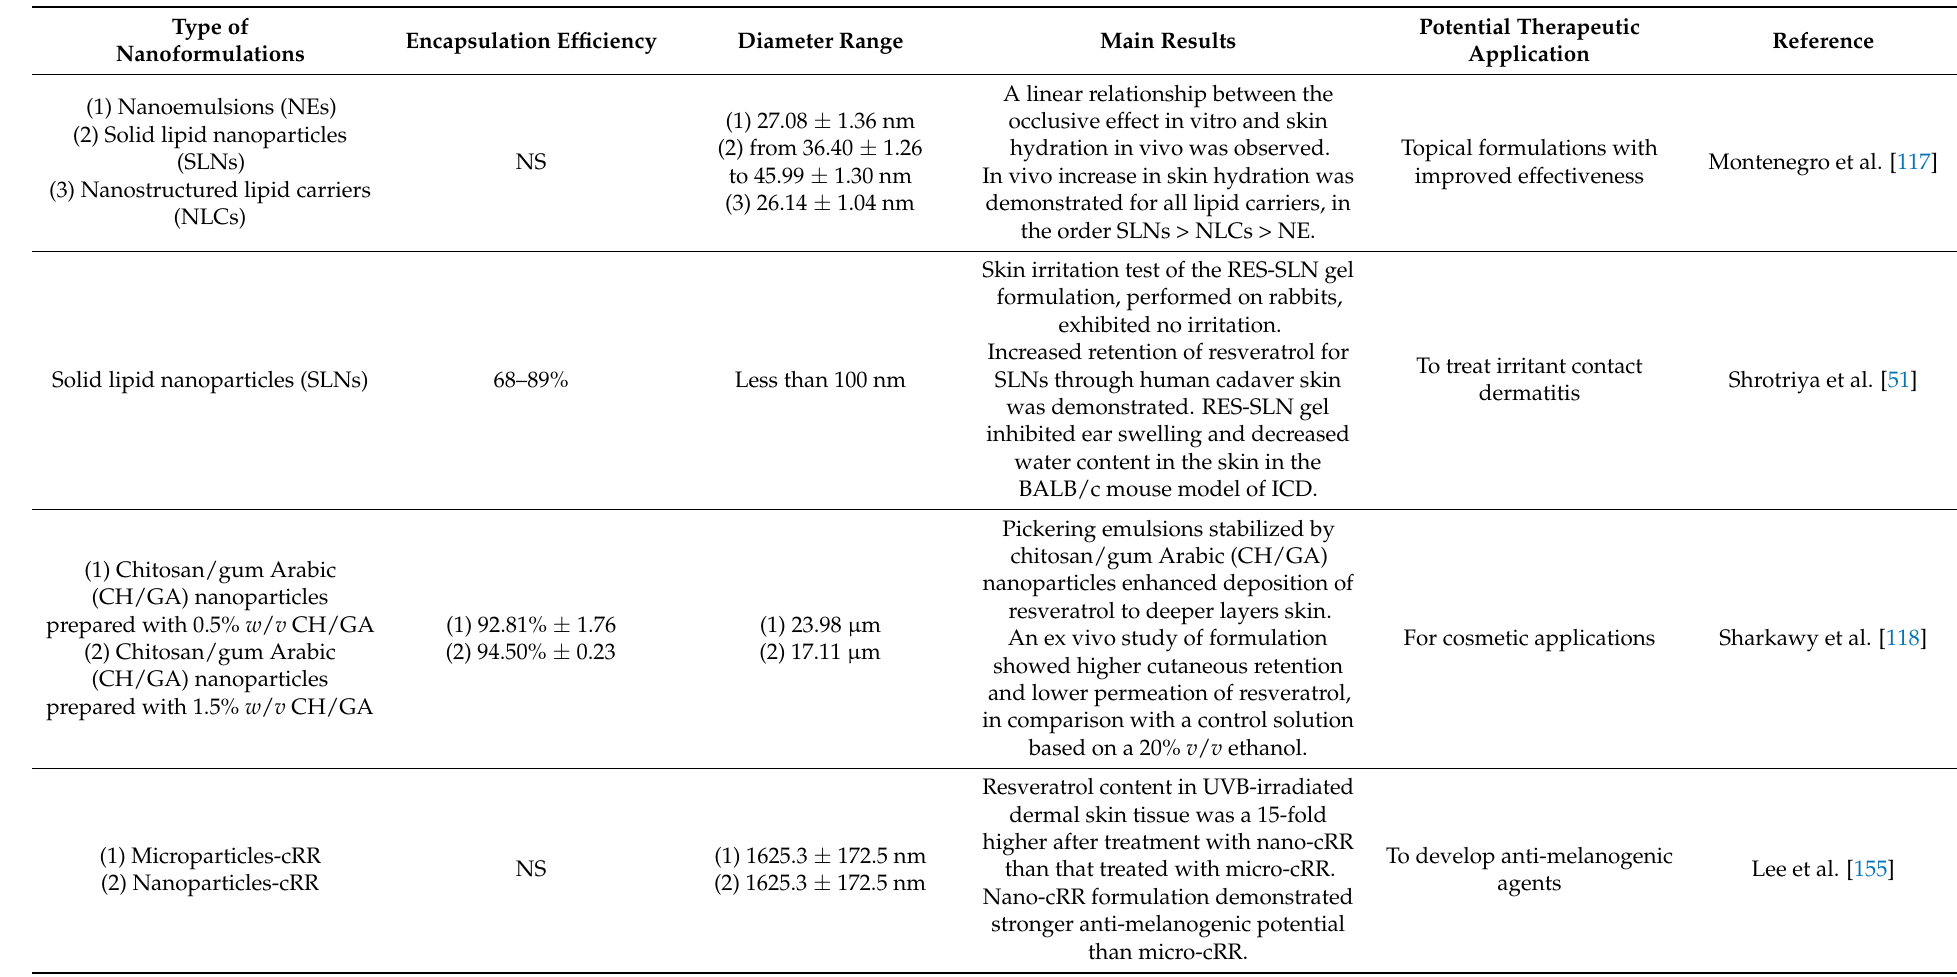
Table 4. Summary of data on nanoformulations of resveratrol for topical